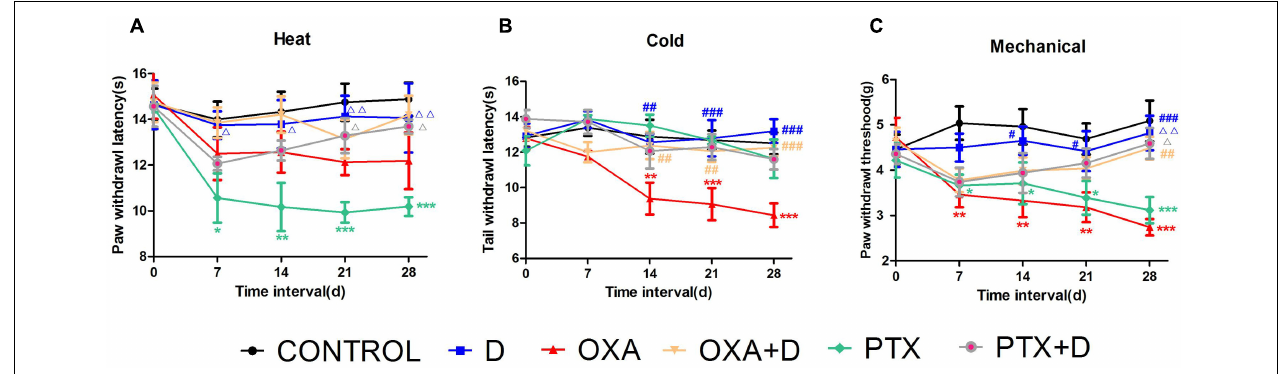
FIGURE 4 | Partial prevention by duloxetine against OXA or PTX-induced peripheral neuropathy in ICR mice. (A) The effect of duloxetine on the heat withdrawal latency in mice treated with vehicle or chemotherapeutic drugs (OXA and PTX) was evaluated. (B) The effect of duloxetine on the cold threshold in mice treated with vehicle or chemotherapeutic drugs (OXA and PTX) was determined. (C) The effect of duloxetine on the mechanical withdrawal threshold in mice treated with vehicle or chemotherapeutic drugs (OXA and PTX) was assessed. ( ∗ p < 0.05, ∗∗ p < 0.01, ∗∗∗ p < 0.001 vs. control; # p < 0.05, ## p < 0.01, ### p < 0.001 vs. OXA; (cid:49) p < 0.05, (cid:49)(cid:49) p < 0.01 vs. PTX ). The data are presented as the mean ± SEM ( n = 5–8).